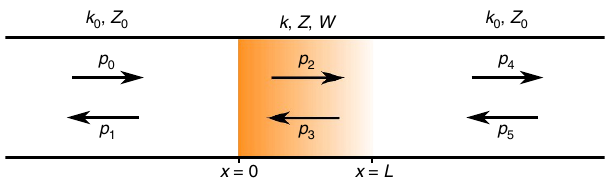
Figure 1 | Schematic of a three-medium reflection–transmission problem. The middle layer is assumed to be a Willis material with wavenumber k , characteristic impedance Z and asymmetry coefficient W . The materials on the left and right are a uniform background medium with wavenumber k 0 and characteristic impedance Z 0 . The pressures p 0 , p 2 and p 4 represent right-propagating waves and the pressures p 1 , p 3 and p 5 represent left-propagating waves.